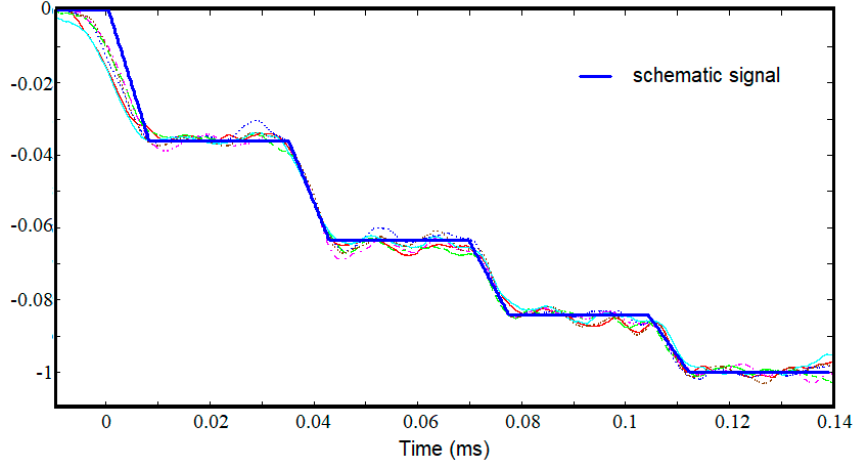
Figure 7. Schematic signal superimposed on experimental signals.